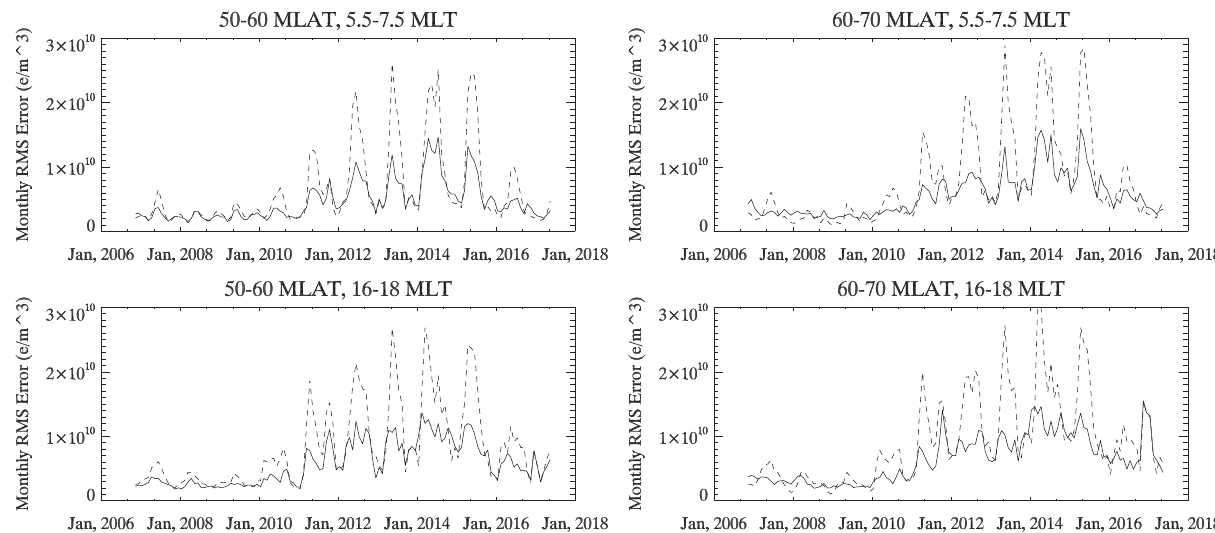
Fig. 6. Monthly RMS errors in E-CHAIM (solid lines) and IRI (dashed lines) electron density at the DMSP F17 satellite. The top plots correspond to the 5.5 – 7.5 MLT bin, the bottom plots correspond to the 16 – 18 MLT bin, the left plots are for the 50 (cid:1) – 60 (cid:1) N geomagnetic latitude bin, and the right plots are for the 60 (cid:1) – 70 (cid:1) N geomagnetic latitude bin.